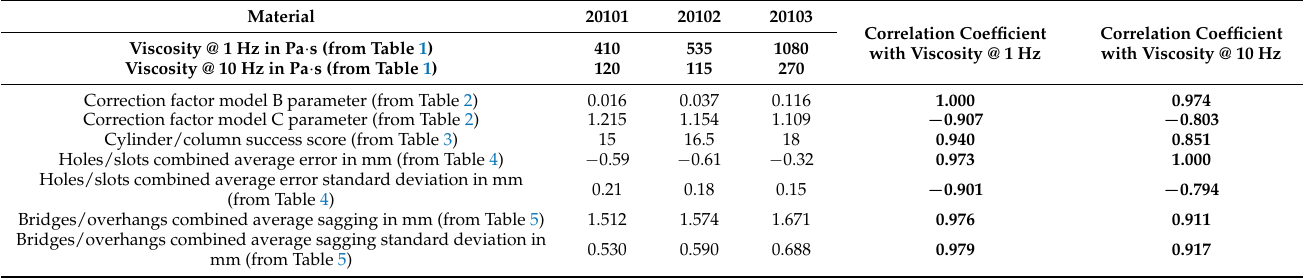
Table 6. Correlations between silicone viscosity and results seen in Tables